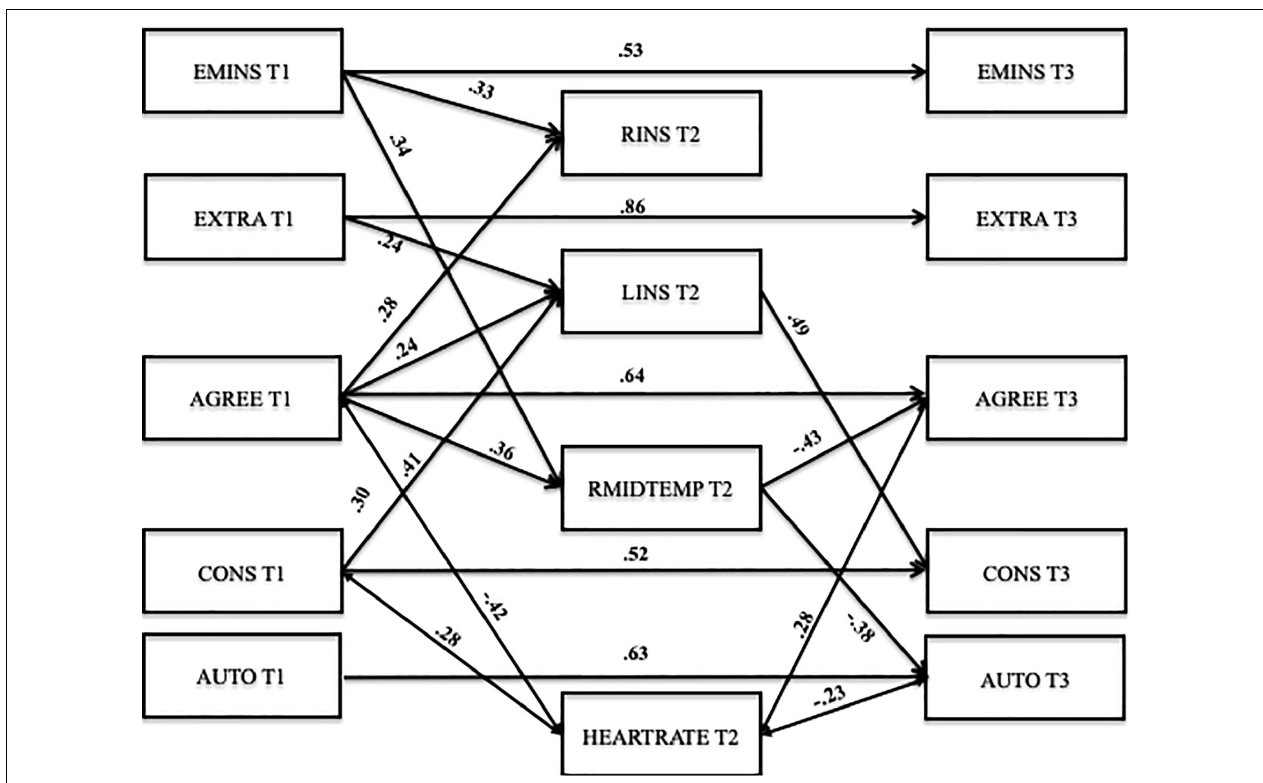
FIGURE 3 | Multiple regression analysis (MRA) with indirect effects. Significant effects ( p < 0.05) shown as standardized coefficients ( β ). For reasons of clarity the non-significant paths are not included in the figure. The covariance between the predictor, mediator and outcome variables are not included in the figure but explained in the manuscript. Emins, emotional instability; Extra, extraversion; Agree, agreeableness; Cons, conscientiousness; Auto, autonomy; Rins, right insula; Lins, left insula; Rmidtemp, right middle temporal gyrus; T1, Time 1 (beginning of 8th grade); T2, Time 2; T3, Time 3 (end of 9th grade); brain activation refers to contrast high > low